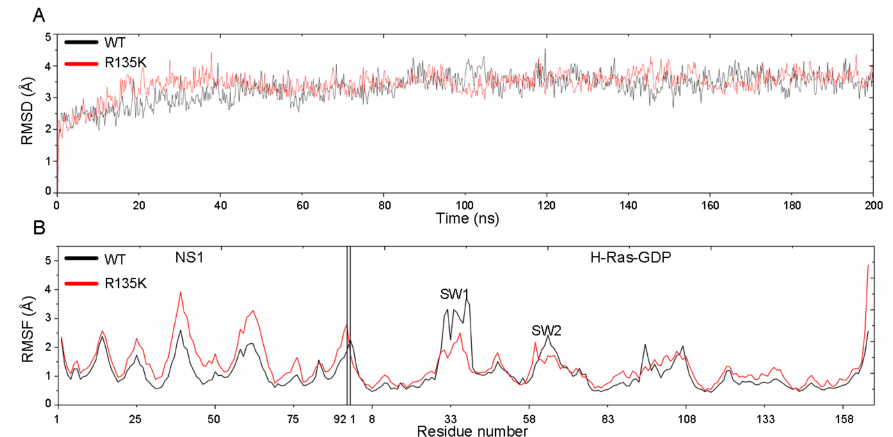
Figure 1. ( A ) RMSD of the wild type and R135K H-Ras–NS1–GDP complexes in 200 ns simulation; ( B ) The C α atoms RMSF of the wild type and mutation system in 200 ns simulation (Residue 1–92 was for NS1, and 1–166 was for H-Ras–GDP).